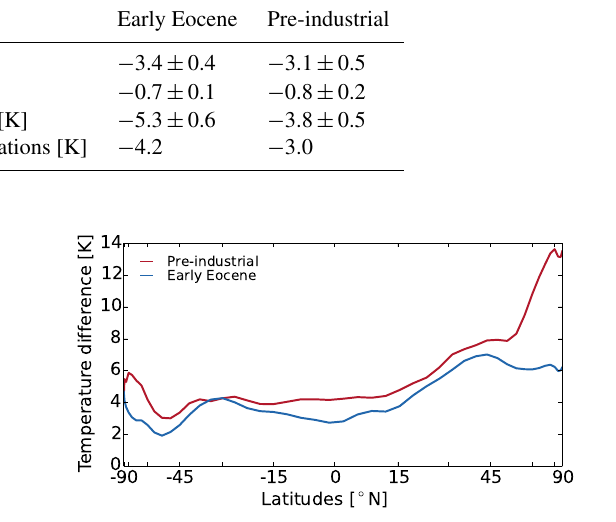
Figure 8. Zonal mean temperature difference between the forest world and the desert world. Red line and blue line refer to the early Eocene climate and the pre-industrial climate, respectively. The av- erage over the last 30 years of the simulation is